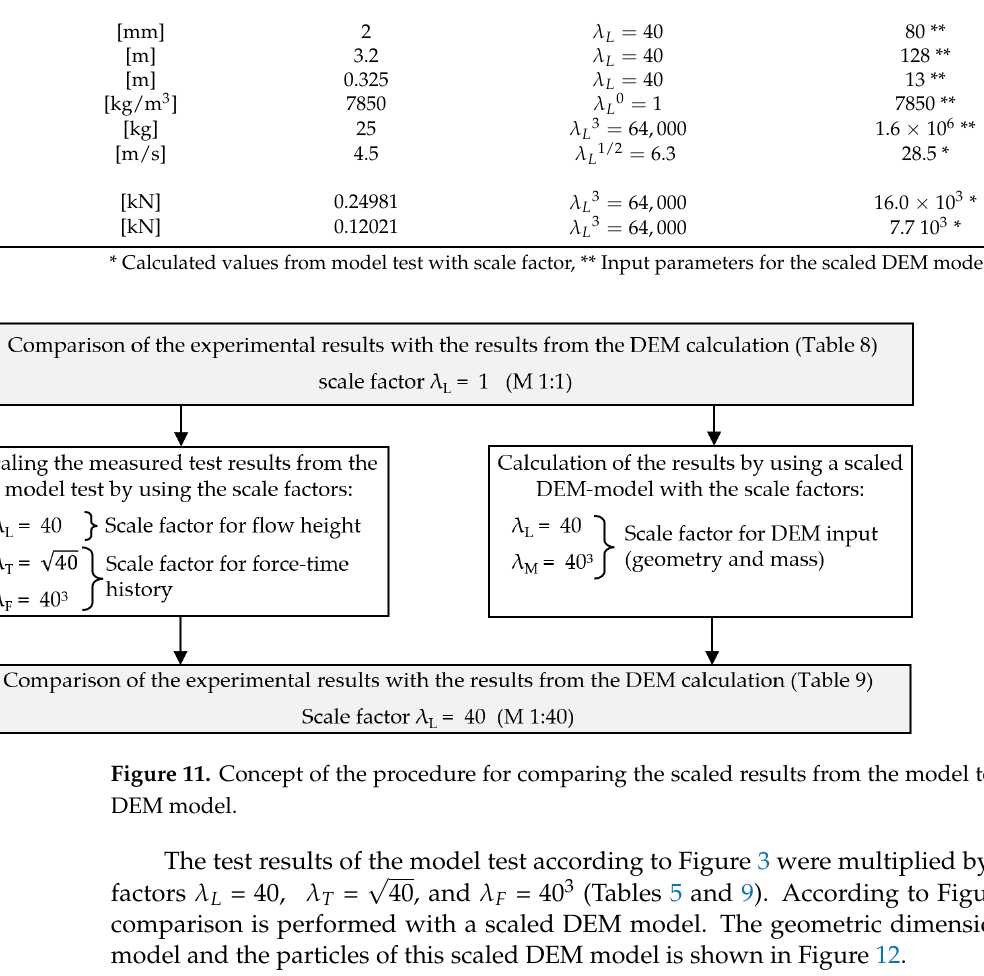
Scaled Measured Values of the Model Test λ L = 40